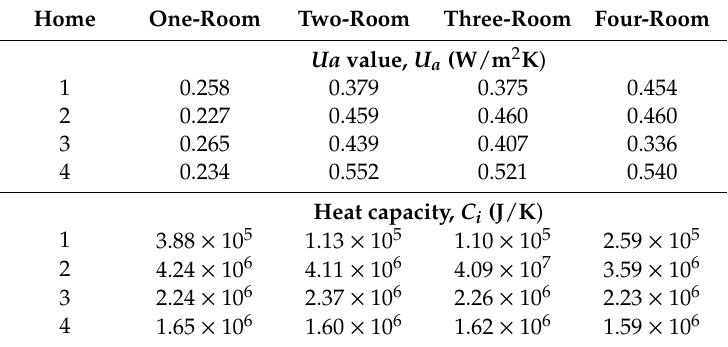
Table 6. Summary of thermal performance parameters for experimental data. The median of estimation results for Ua values ( U a ), and heat capacity ( C i ) for each house (Home 1-4) and models (one-, two-, three-, and four-room).